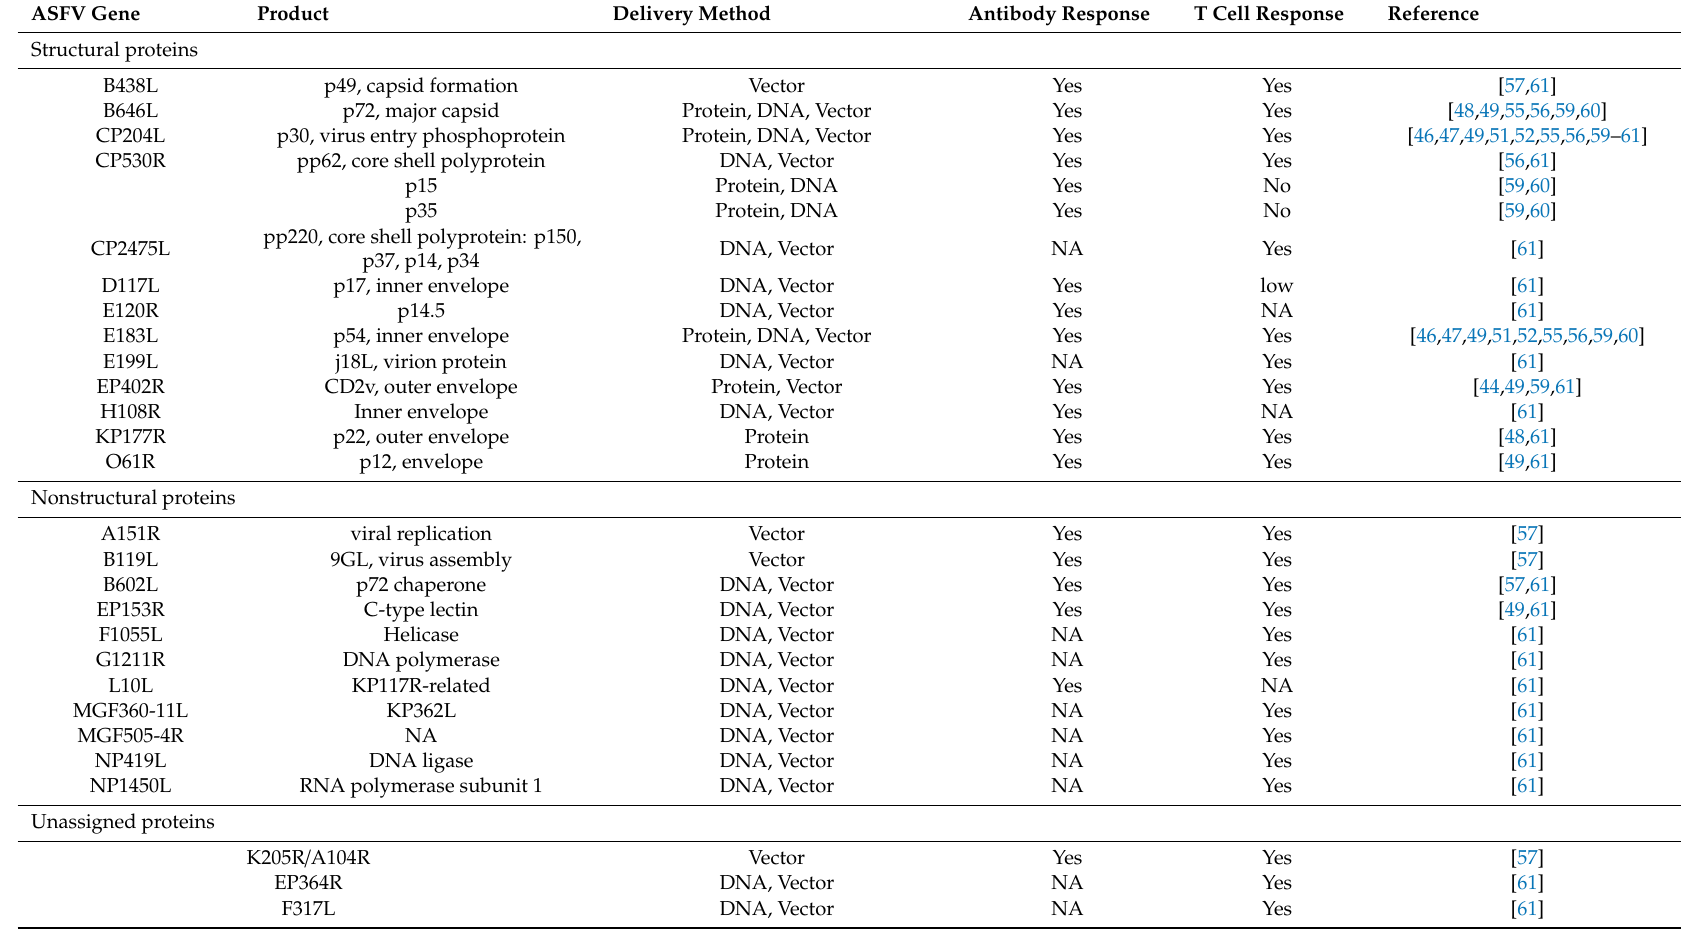
Table 6. Identified ASFV